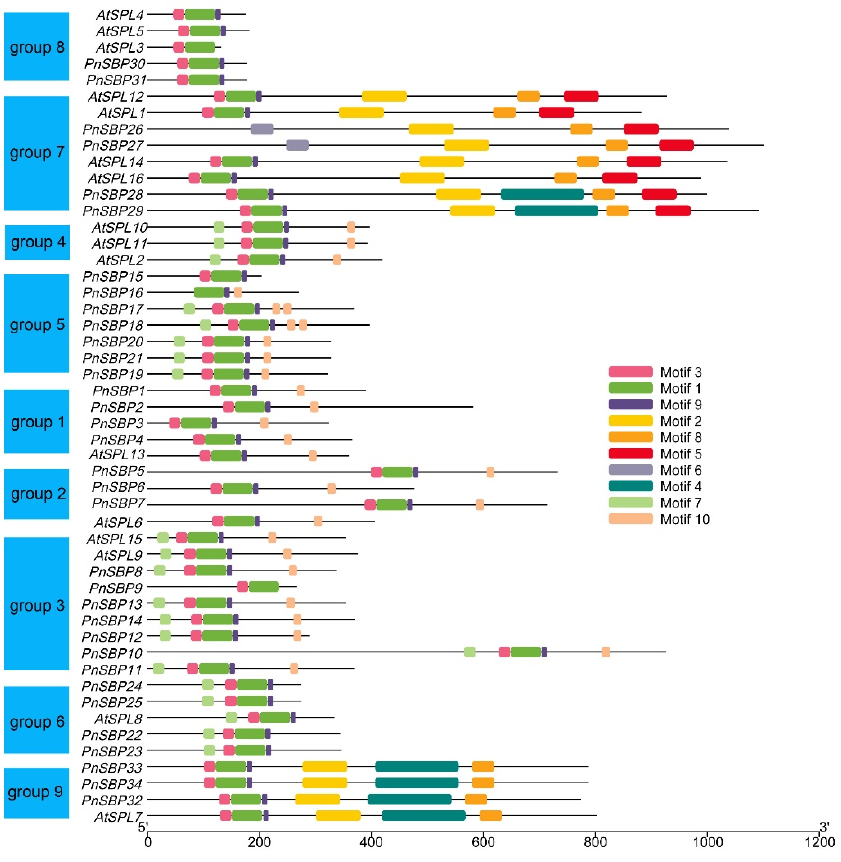
Figure 3. The conserved motifs in pepper SBP genes. The genes in the same group were drawn together, and the group number was marked to the left.